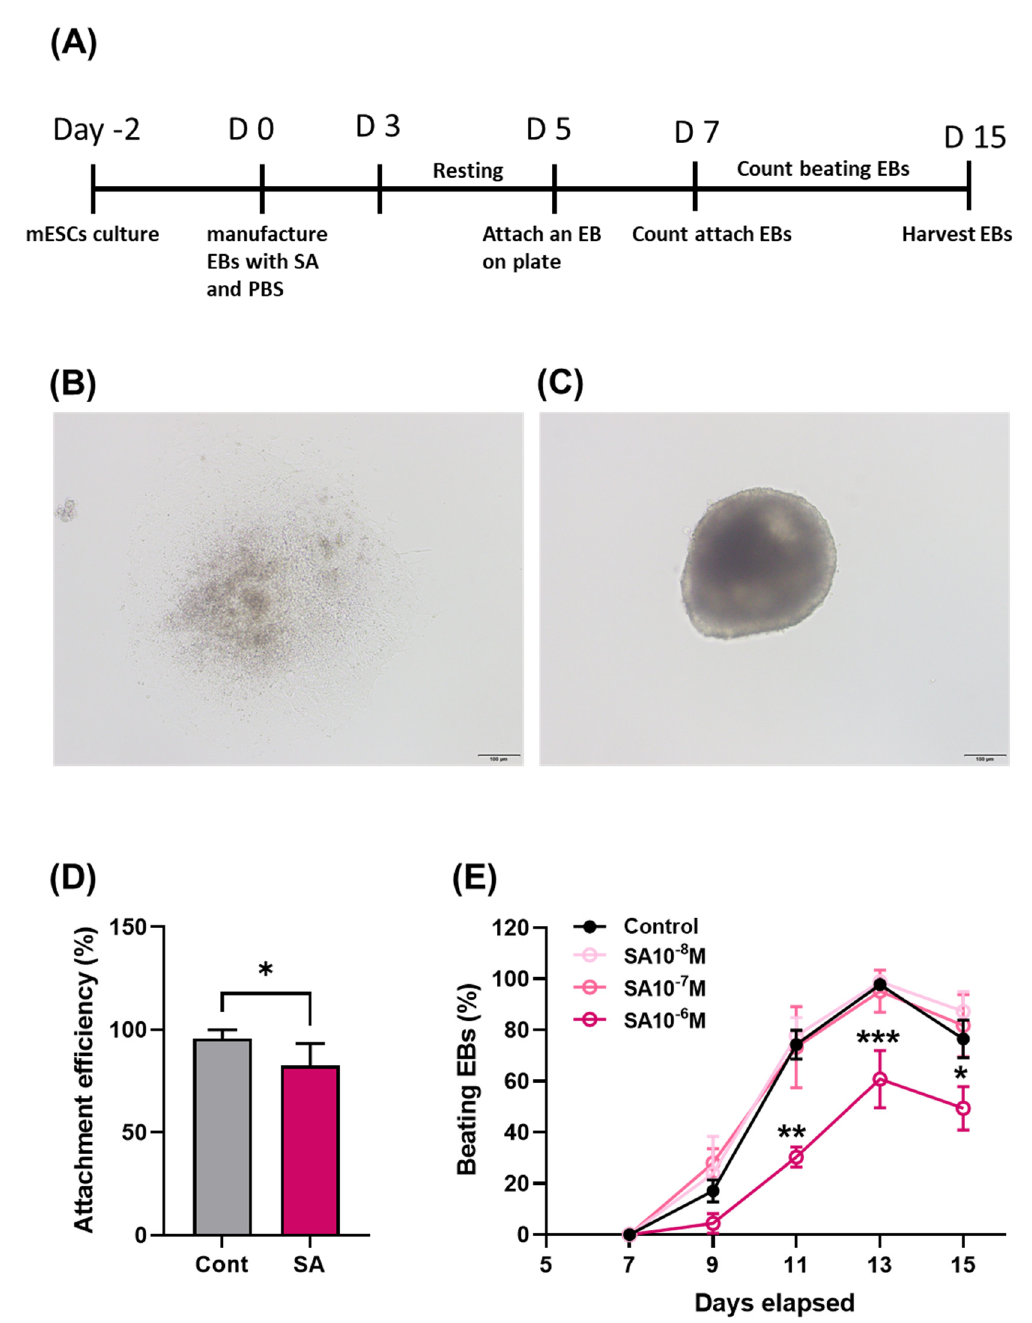
Figure 1. Disruption of myocardial differentiation by sodium arsenite. The cells were treated with SA during cardiomyocyte differentiation. ( A ) Attached form and ( B , C ) unattached form of EBs two days later. Scale bar = 100 µ m. ( D ) Attachment efficiency when inducing cardiomyocyte differentiation two days later (n = 24). ( E ) Time- and dose-dependent cardiomyocyte beating ratio (n = 24). The significance was determined by ANOVA. * p < 0.05, ** p < 0.01, and *** p < 0.001 vs. control. * Control vs. SA 10 − 6 M, # SA 10 − 7 M vs. SA 10 − 6 M, and & SA 10 − 8 M vs. SA 10 − 6 M. Each value is expressed as means ± SD. n = 3, Cont; control, SA; sodium arsenite.